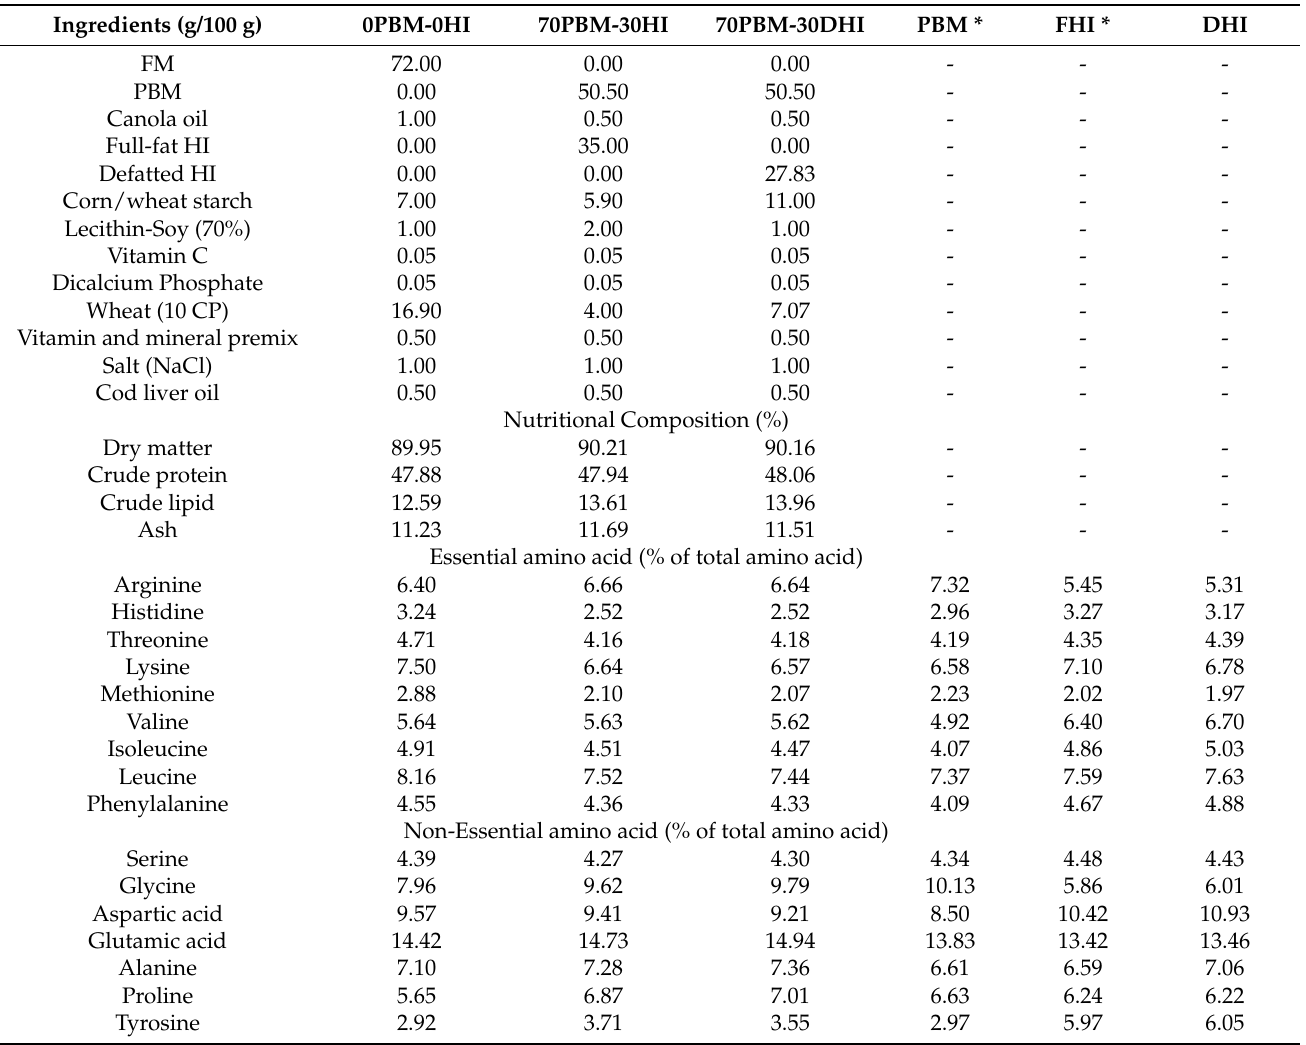
Table 1. The nutrient contents of the test diets and different ingredients such as poultry by-product meal (PBM), full-fat Hermetia illucens (FHI), and partially defatted Hermetia illucens (DHI). The ingredients and proximate compositions were previously published in our earlier article